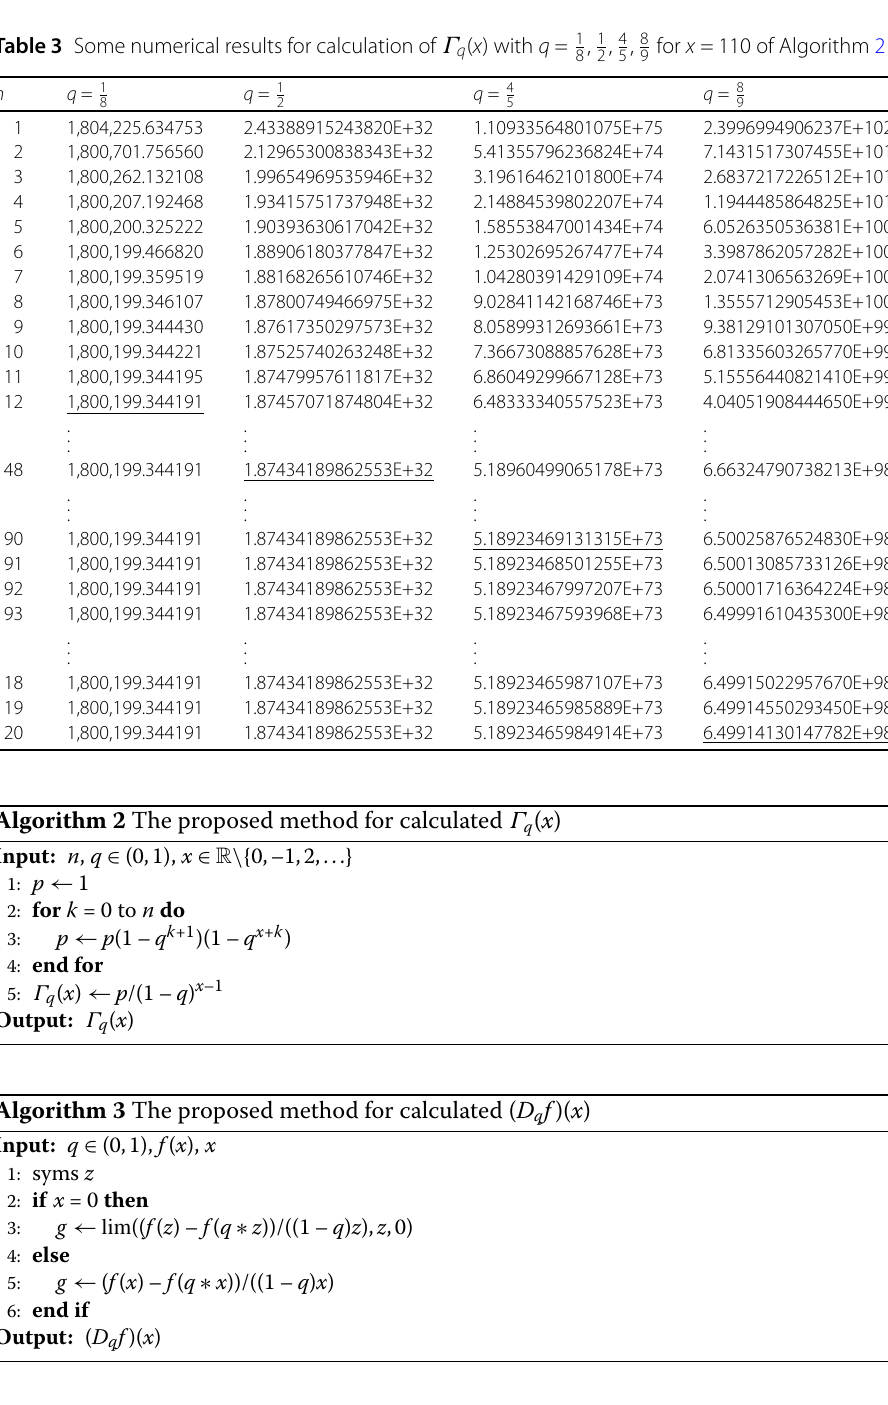
Table 3 Some numerical results for calculation of Γ q ( x ) with q = 1